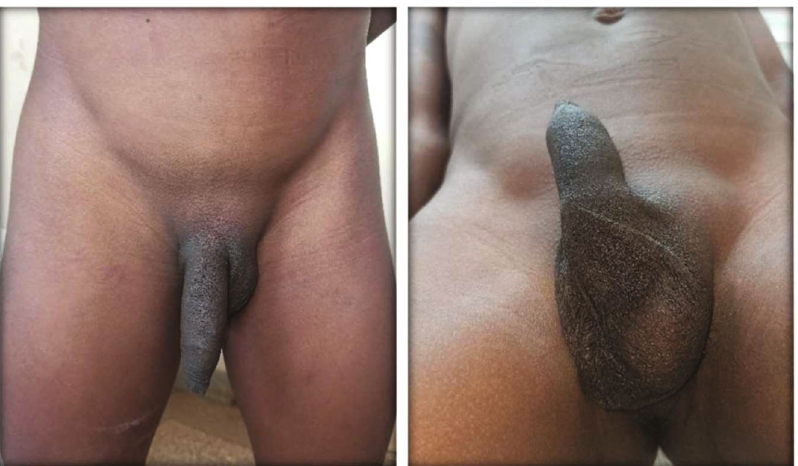
Figure 1: Patient in standing and lying positions showing hypoplasia of right hemiscrotum and left suprascrotal bulge.